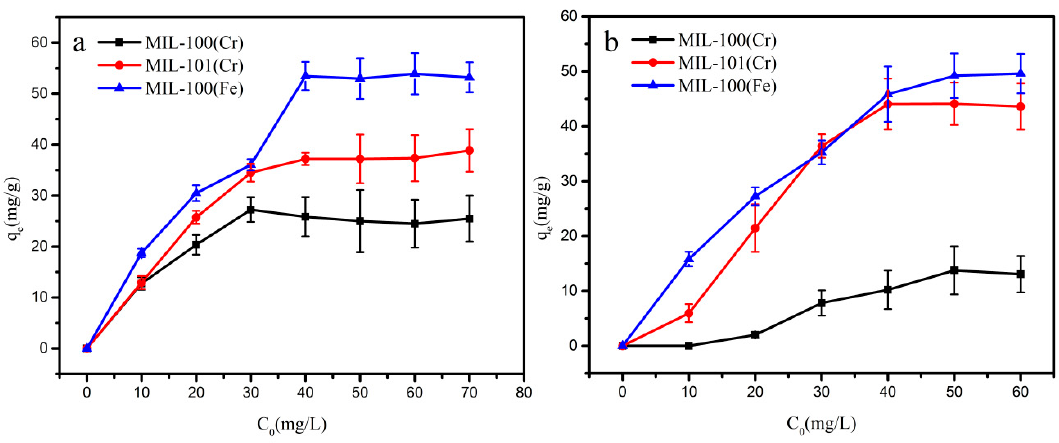
Figure 5. Adsorption isotherms for ( a ) 1-naphthylamine and ( b ) o-toluidine adsorption on MIL-100(Fe) (blue), MIL-100(Cr) (black) and MIL-101(Cr) (red).